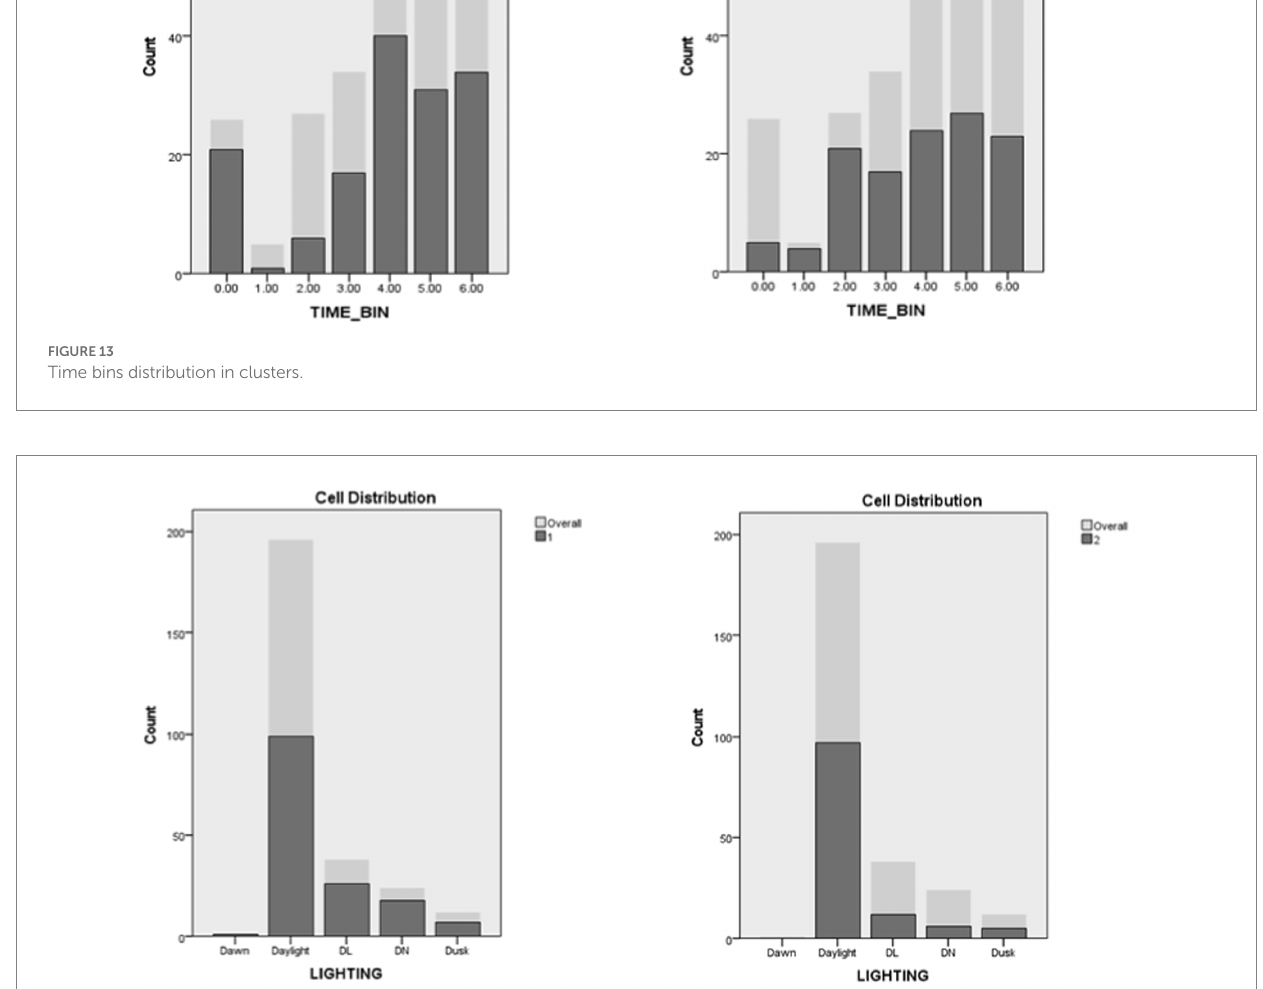
FIGURE 14 Lighting distribution in